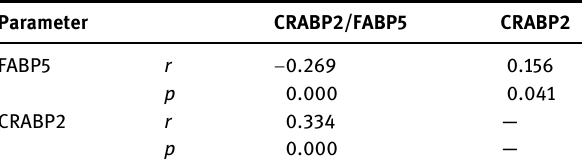
Table 4: Pairwise association between CRABP2 and FABP5 proteins and their ratio Parameter